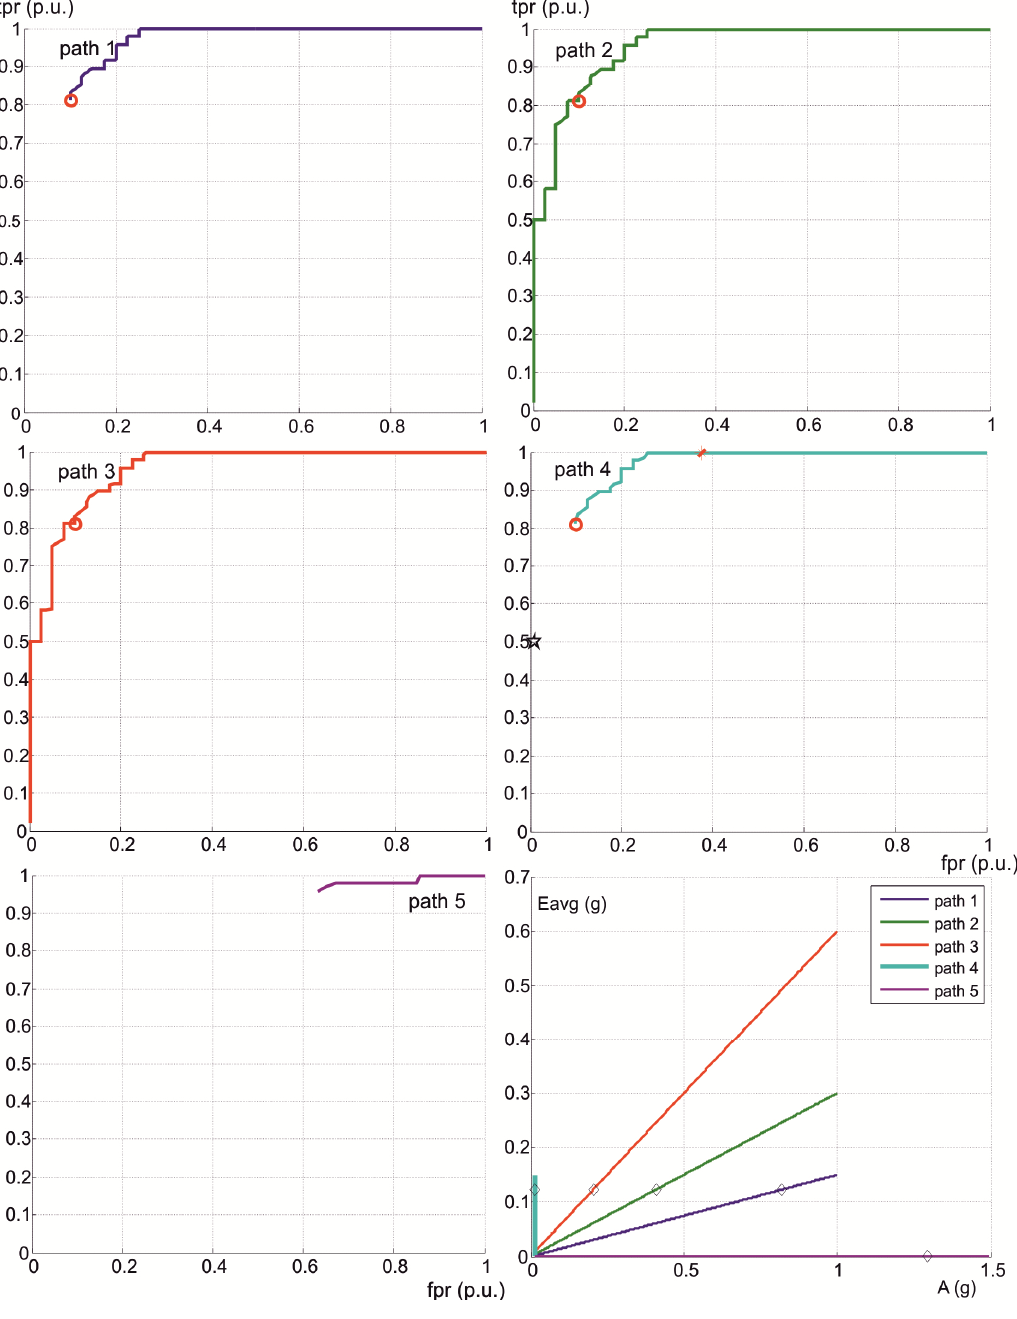
scale) for each avg